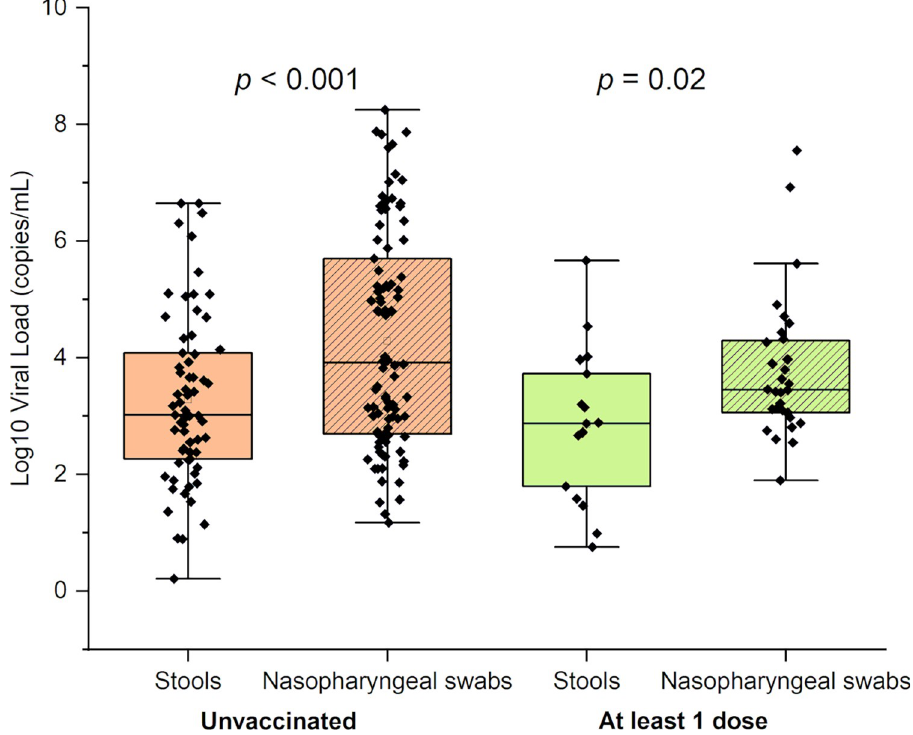
Fig 5. Viral load in stools and nasopharyngeal swabs of unvaccinated and vaccinated (at least 1 dose) participants. The graph presents the median and the minimal to the maximal range of viral load in log10 copies/mL. The significance of the pairwise two-sided t-tests is indicated on top.